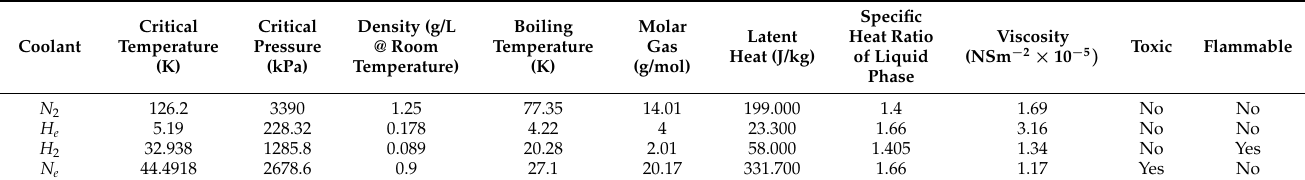
Table 1. Chemical–physical properties of most common fluids in cryogenic cooling systems